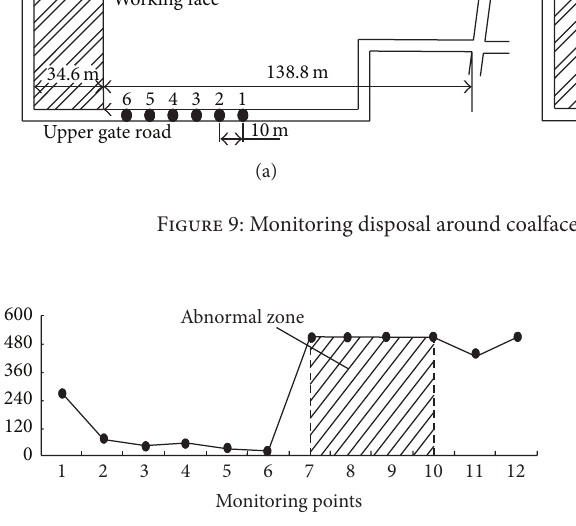
Figure 12: Electromagnetic radiation monitoring results at the final stage of extraction.